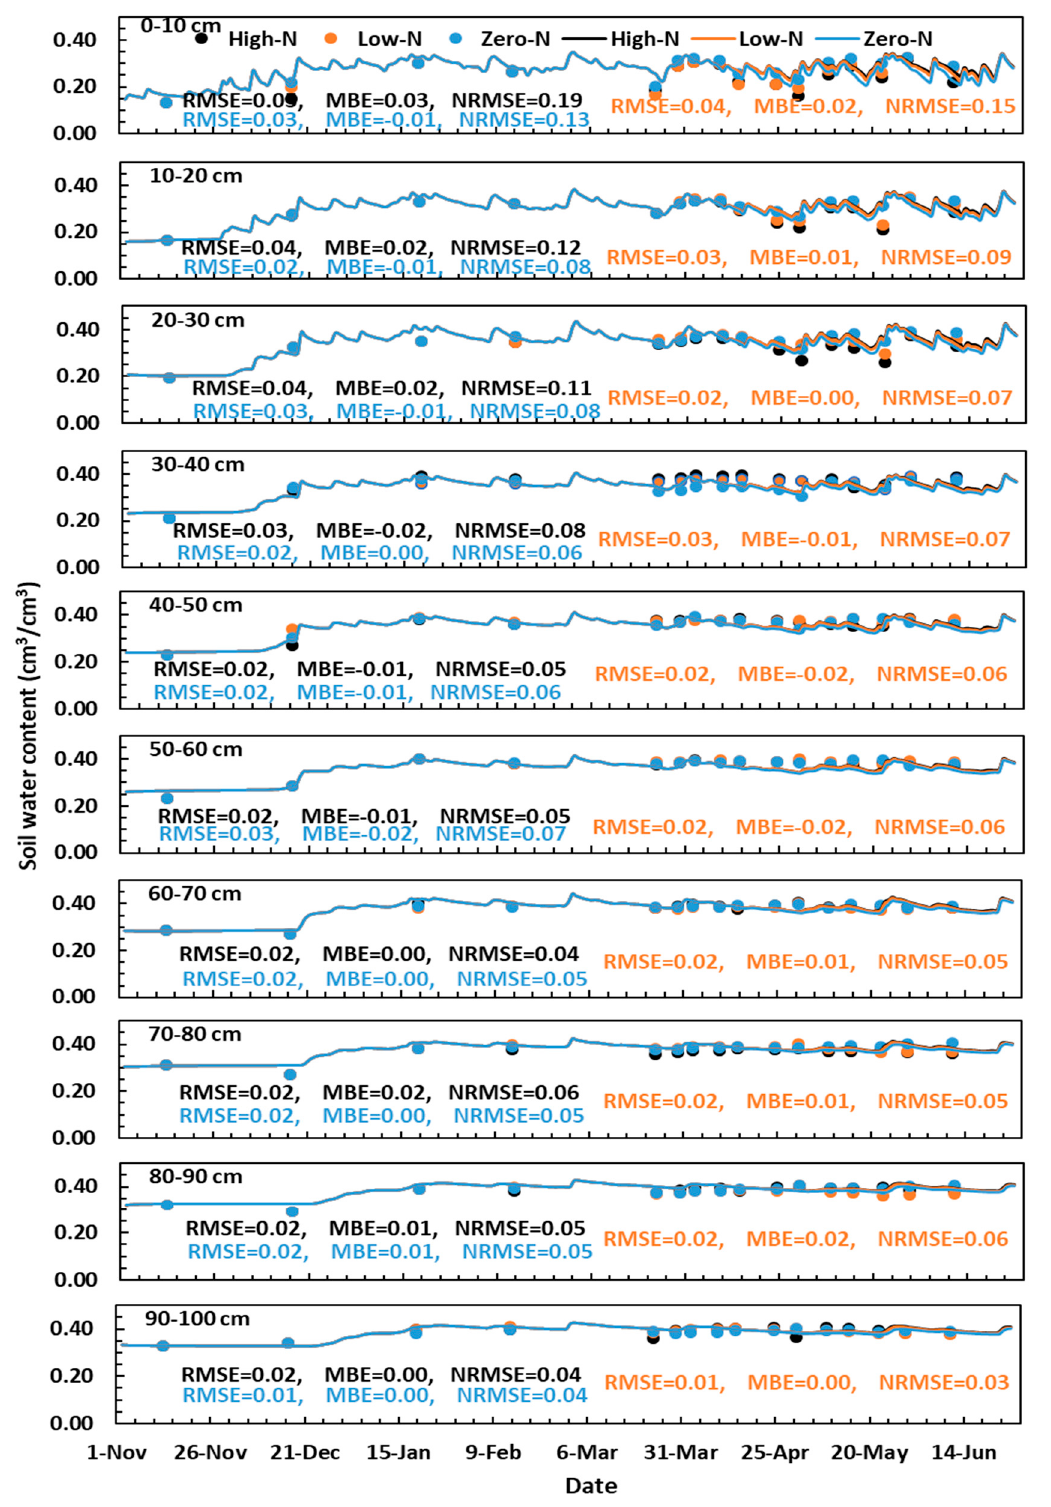
Figure 3. Model-simulated vs. field-measured soil water contents with time in different soil layers for the high N, low N, and zero N rates during the wheat growing season under 100% rainfall.